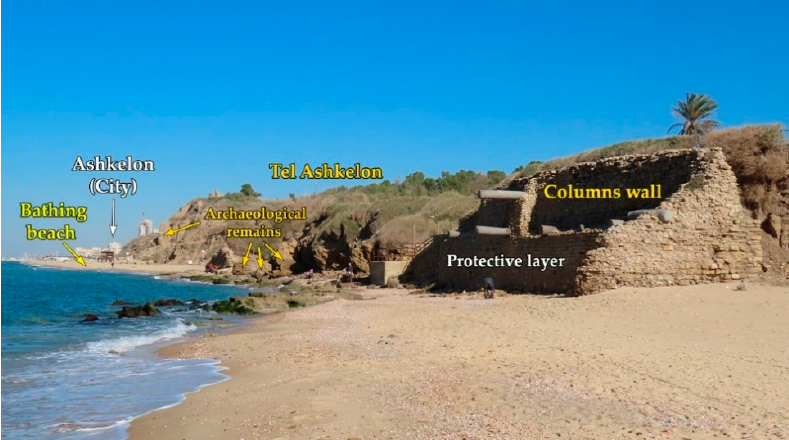
Figure 3. View to northeast of the eroded beach in southern Tel Ashkelon, at the vicinity of the Columns wall (photographed by Dov Zviely, 19 December 2019).